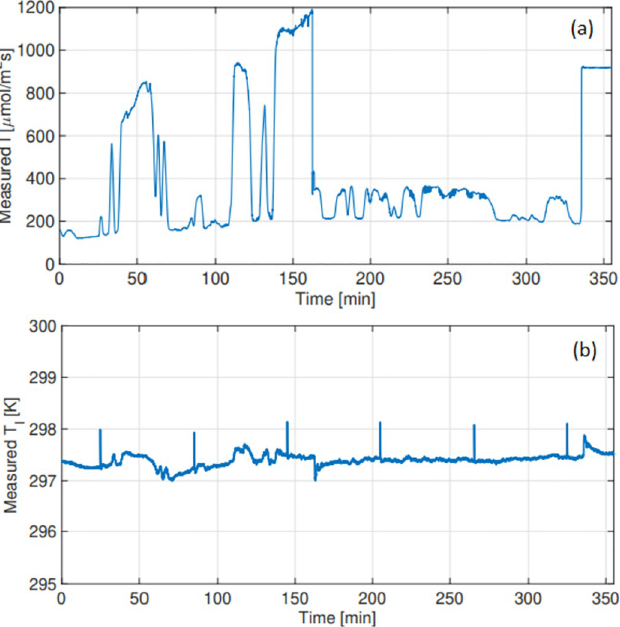
Fig 1. Parameter estimation data set: Model inputs measured on 8 September 2021. (a) Measured irradiance (I) μmolm − 2 s − 1 (b) Measured leaf temperature (T l )